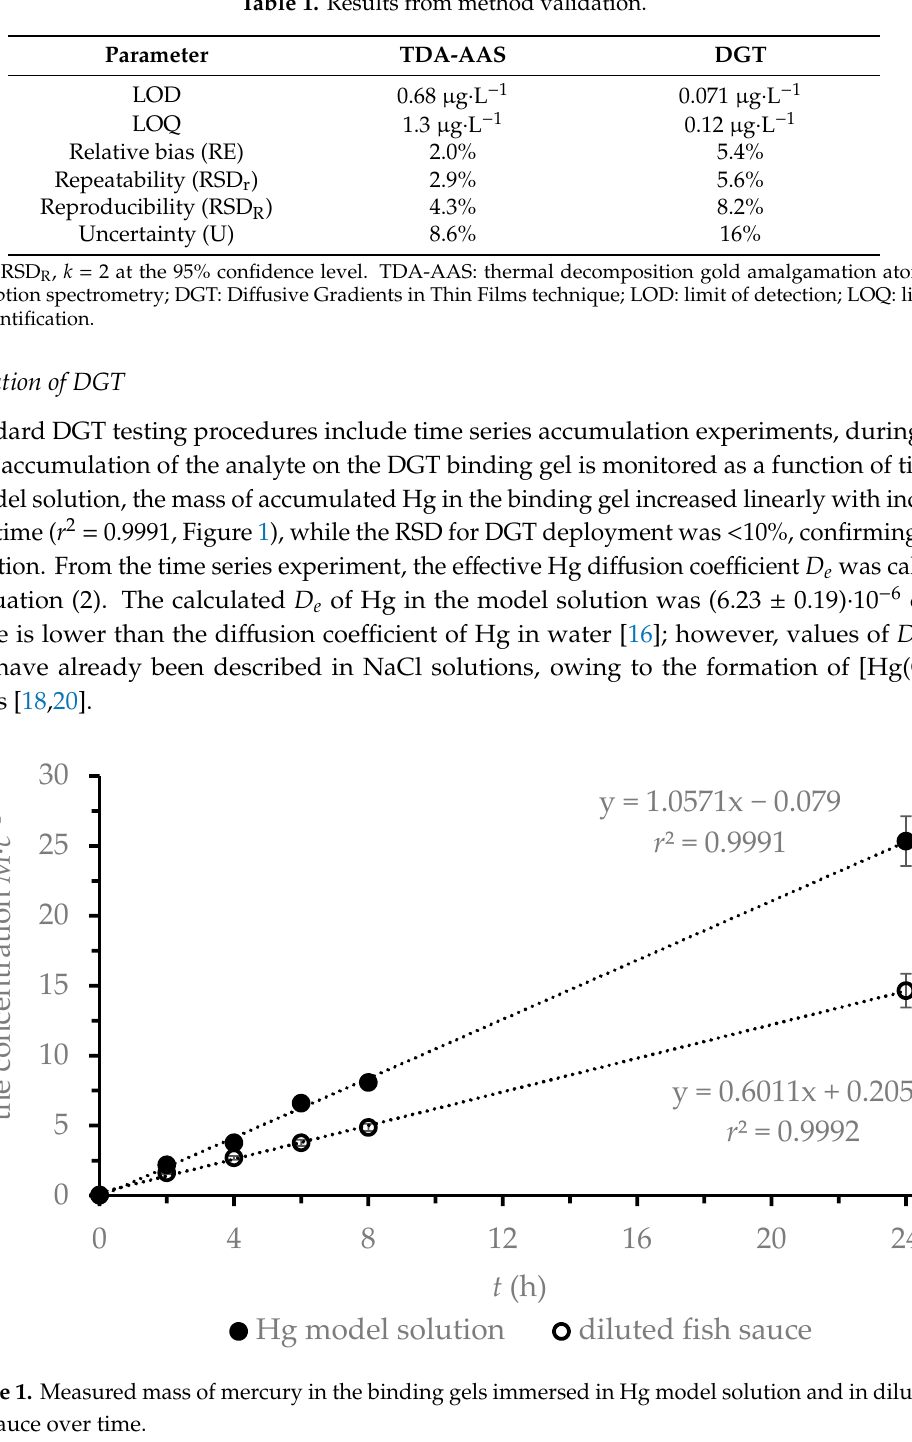
Table 1. Results from method validation.